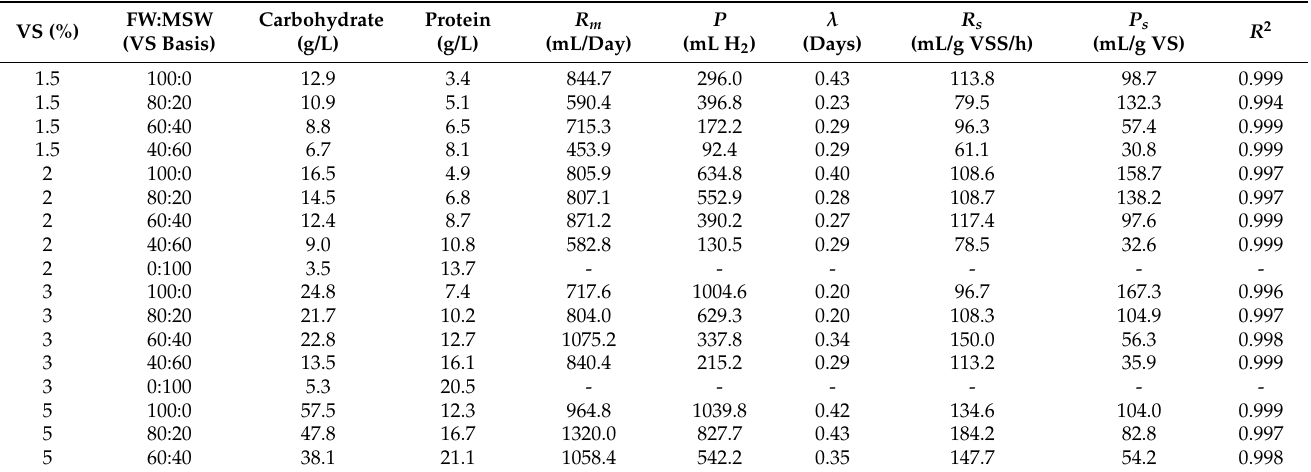
Table 2. Kinetic parameters of hydrogen